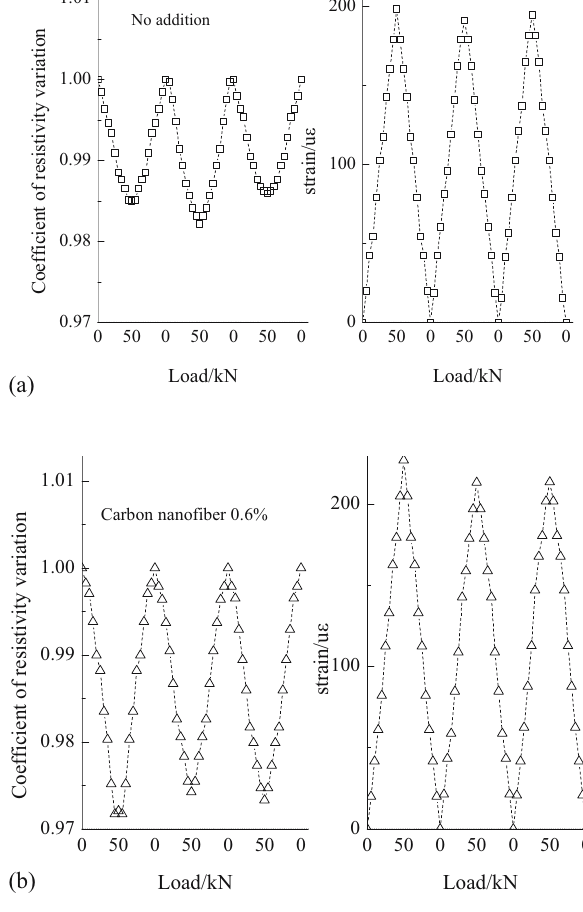
Figure 5: Relationship of coe ffi cient of resistivity variation, strain and load: ( a ) no addition, ( b ) carbon nano fi